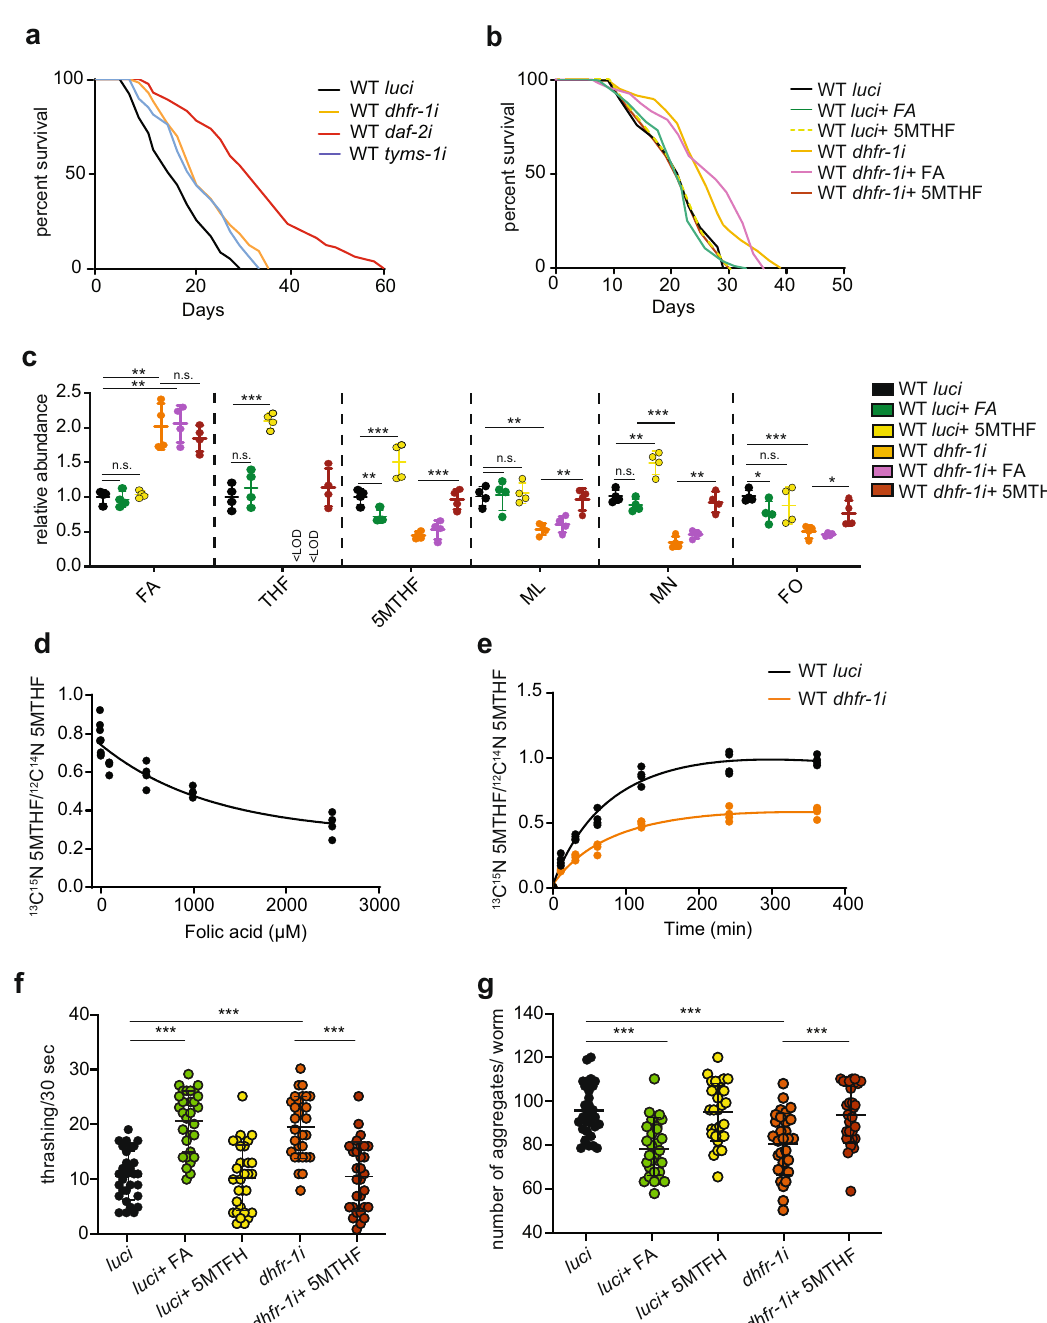
Fig. 2 dhfr-1i prolongs nematode life span in a 5MTHF dependent manner. a dhfr-1 and tyms-1 RNAi treatment increase wild-type life span (from L4 stage). b Supplementation of 10 nM 5MTHF abolishes dhfr-1i longevity (from L4 stage). c Quantitation of folic acid intermediates using targeted mass spectrometry in wild-type worms (day 1) with luci and dhfr-1i treatment in the presence or absence of folic acid and 5MTHF. dhfr-1i increases folic acid and decreases 5MTHF and downstream intermediates. d Increasing concentrations of FA inhibit 13 C 15 N labeled 5MTHF incorporation within a 2 h time period (day 1 adult). e Incorporation of 13 C 15 N labeled 5MTHF over time in worms with luci (black line) and dhfr-1i (orange line) (day 1 adult) each dot represents a single biological replicate. f Thrashing assay of polyQ35 worms (day 7 adult). g Protein aggregate quantitation in polyQ40 model (day 7 adult). dhfr-1i or FA supplementation are bene fi cial, whereas 5MTHF is detrimental for motility and aggregate accumulation. Each dot represents a single worm. a , b n = 150 worms per repeat per condition, N = 3 biological replicates. c N = 5 biological replicates. d , e N = 4 independent biological replicates. f , g n = 30 worms, N = 3 independent biological replicates, only one biological replicate is shown. a , b Statistics were performed with the two-sided Mantel – Cox log-rank test (Supplementary Table 7 for statistics). c , f , g Signi fi cance was assessed using one-way ANOVA and Dunnett ’ s multiple comparisons test. * p < 0.5, ** p < 0.01, *** p < 0.001. Data are presented as mean ± S.D. (Supplementary Table 8 for statistics).